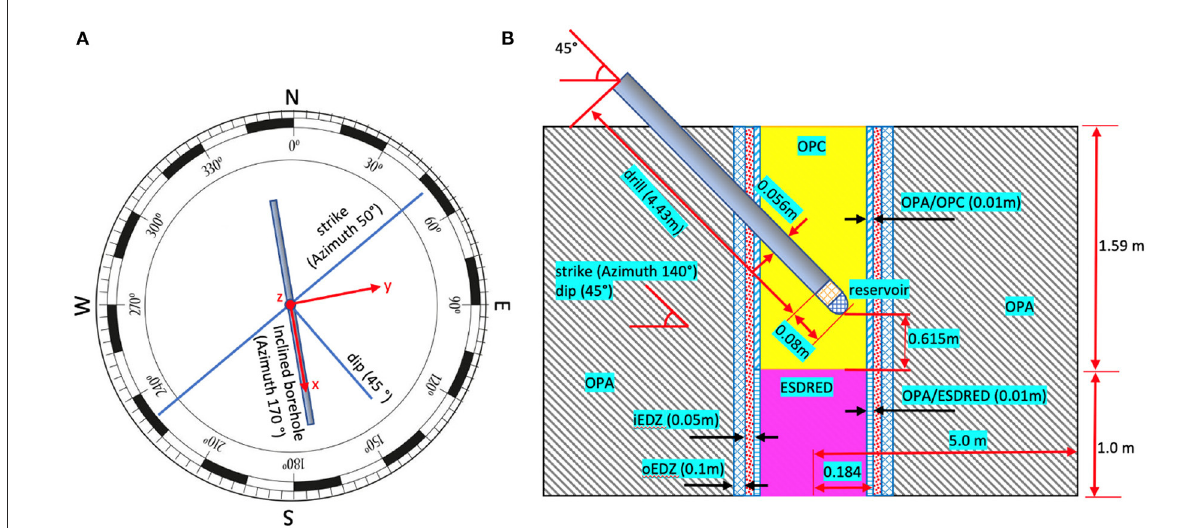
FIGURE5 Illustration of in-situ experiment, (A) plan view and (B) section view.